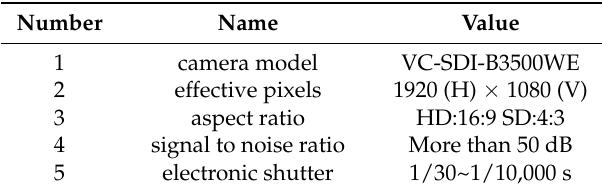
Figure 2. Monitoring area. Table 4. Camera parameters.